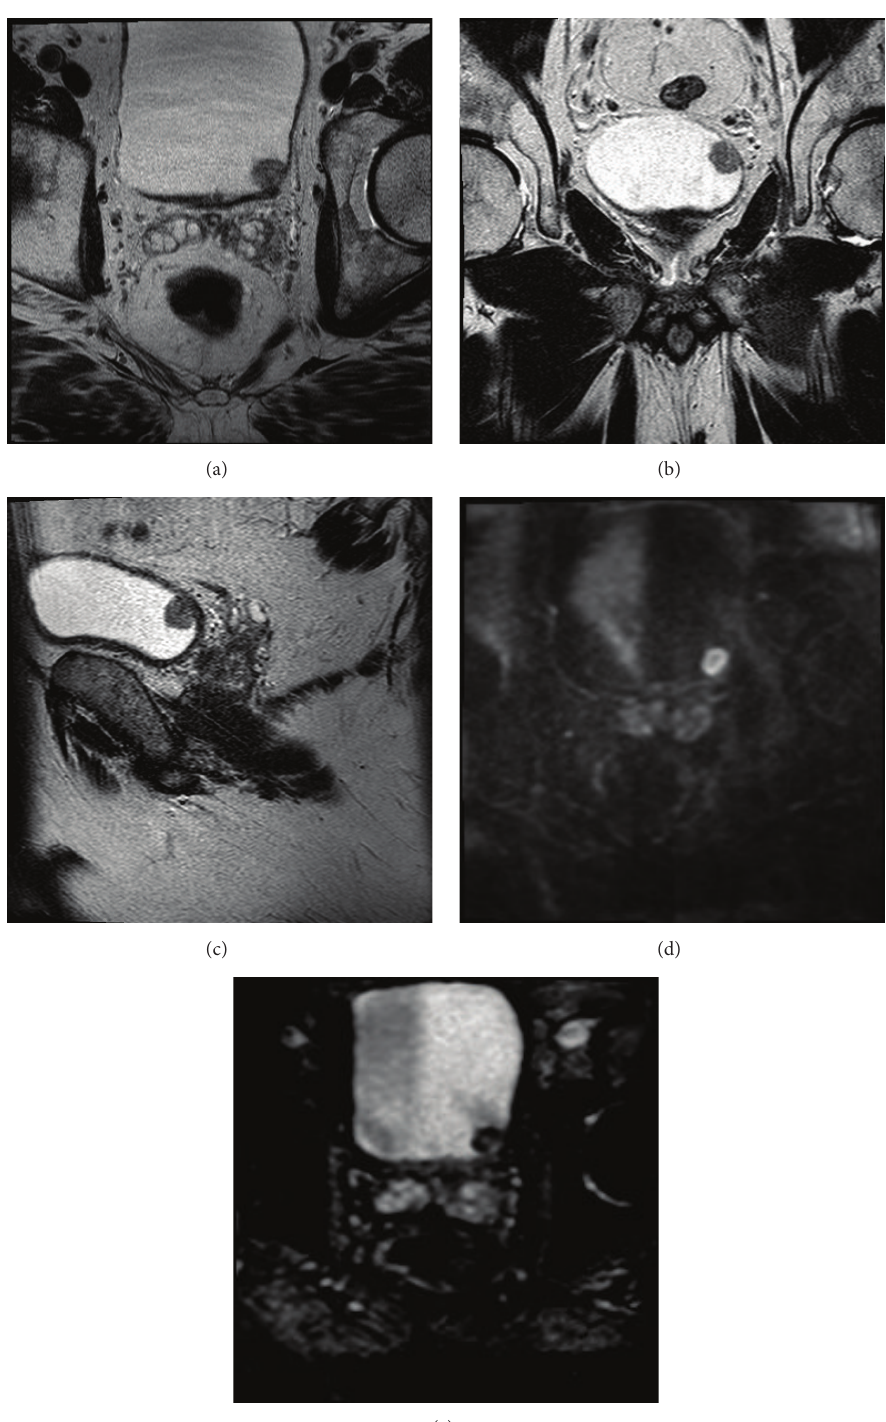
Figure 1: ((a), (b), and (c)) Axial, coronal, and sagittal T2 weighted images showing a nodule in left bladder base as a papillary mass of the bladder wall. ((d) and (e)) DWI B2000 and ADC images showing restricted diffusion of bladder